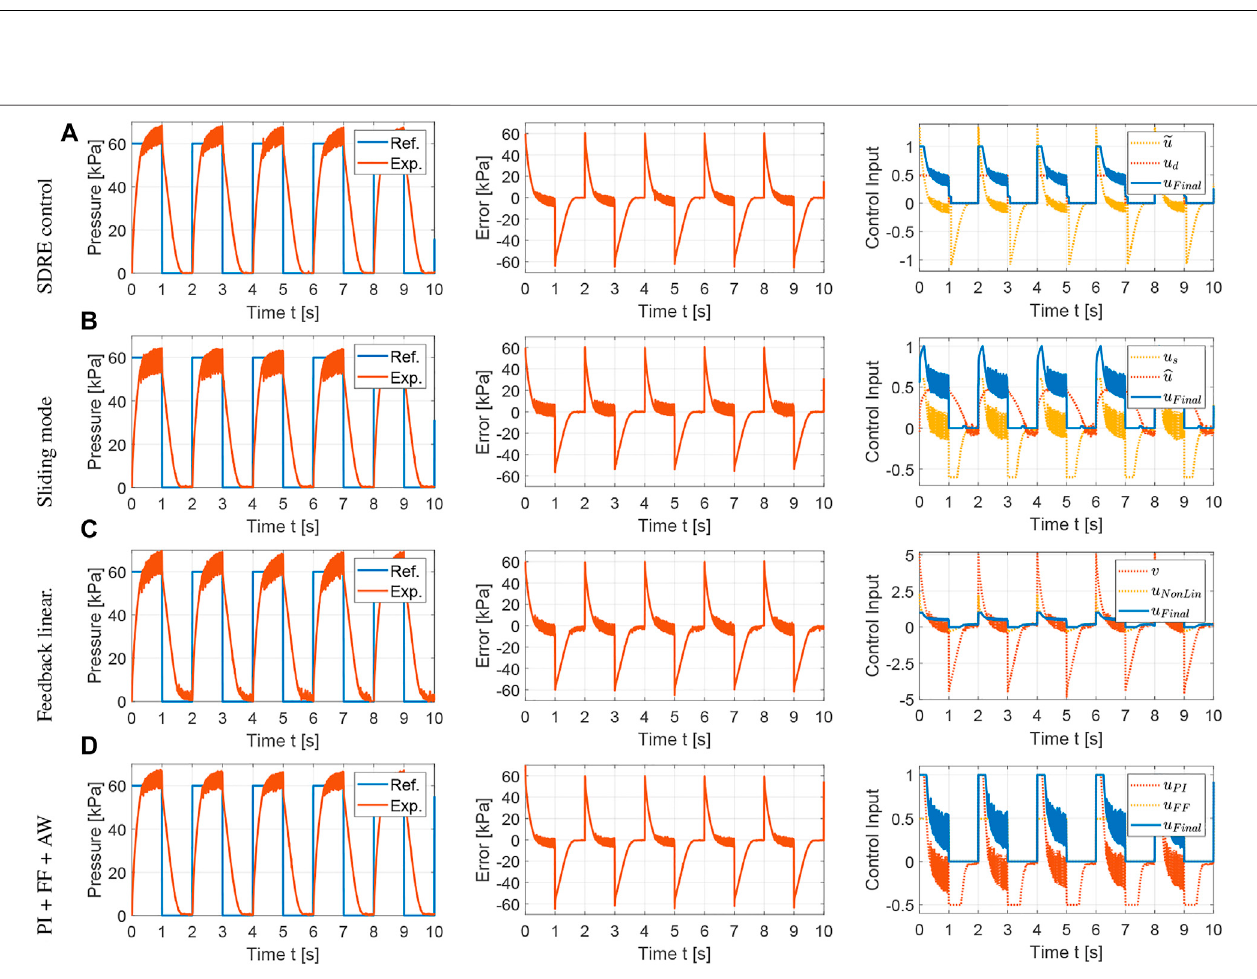
FIGURE7| Experimental results for the comparison of nonlinear control strategies: tracking performance, tracking error and control input for square wave with T = 2 s. (A) SDREcontrol: Q (cid:1) 5and R (cid:1) 10. (B) Integralaugmentedslidingmodecontrol: k s (cid:1) 0 . 6, k i (cid:1) 0 . 01,and Φ (cid:1) 0 . 2. (C) Feedbacklinearizationwithintegralaction: k (cid:1) 8 and k i (cid:1) 0 . 01. (D) PI controller with feedforward and anti-windup: k p (cid:1) 5 and k i (cid:1) 0 . 5. The description for the control input terms is the same as in Figure 3 .